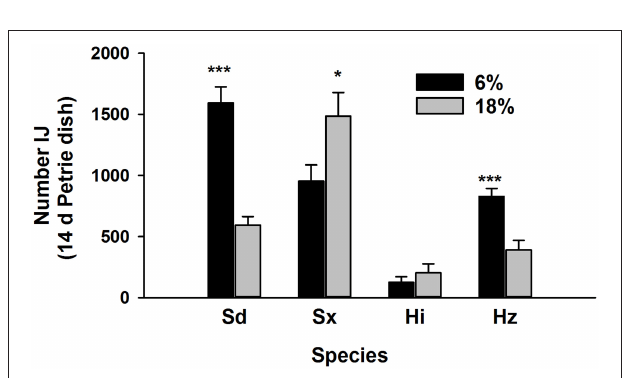
FIGURE 4 | Recovery of four species of entomopathogenic nematodes (Sd = Steinernema diaprepesi , Sx = Steinernema sp., Hi = Heterorhabditis indica , Hz = H. zealandica ) after 14 days in Petrie dishes filled with sand moistened to field capacity (6%) or saturated (18%). Significant differences in recovery from each moisture for each species denoted by *** P < 0.001 and * P < 0.05.